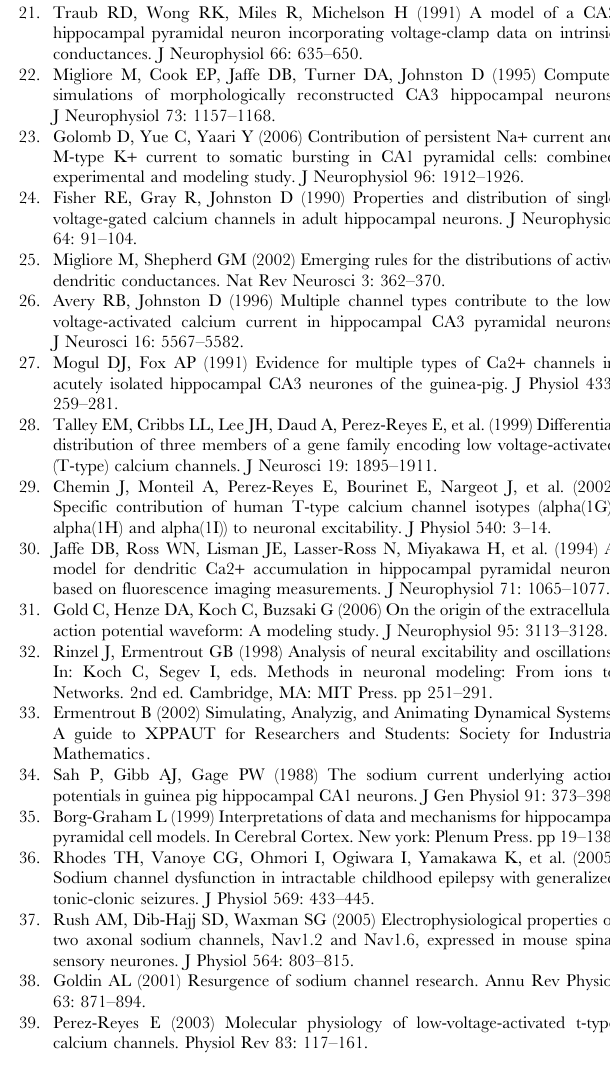
variable recovery period are normalized to peak current during first pulse. C: The time course of T-type Ca2 + currents for models and experiments are shown in response to a 100ms test pulse to 2 25 mV (black) or 2 35 mV (red and blue) from a holding potential of 2 110 mV. D: Model fits to experimentally recorded (symbols) normalized current during an action potential waveform clamp. Protocols are the same as in [10]. Found at: doi:10.1371/journal.pone.0002056.g005 (0.23 MB TIF) Figure S3 Fast slow analysis of bursting in a reduced CA3 model. The phase plot shows the projection of the burst trajectory onto the slow-variable n-o plane (n: the activation gate of CaV3.2; o: the activation gate of calcium-depend K + channel). Direction of movement is indicated with arrows. (A) gCaT = 0.1 mS/cm2; (B) gCaT = 1.0 mS/cm2; (C) gCaT = 1.5 mS/cm2; (D) gCaT = 2.0 mS/cm2. The red curve is the voltage nullcline (dV/dt = 0) of the fast subsystem with n and o as parameters. The region above the nullcline is the unstable firing region. Below the curve is the stable rest region. Found at: doi:10.1371/journal.pone.0002056.g006 (0.53 MB TIF)